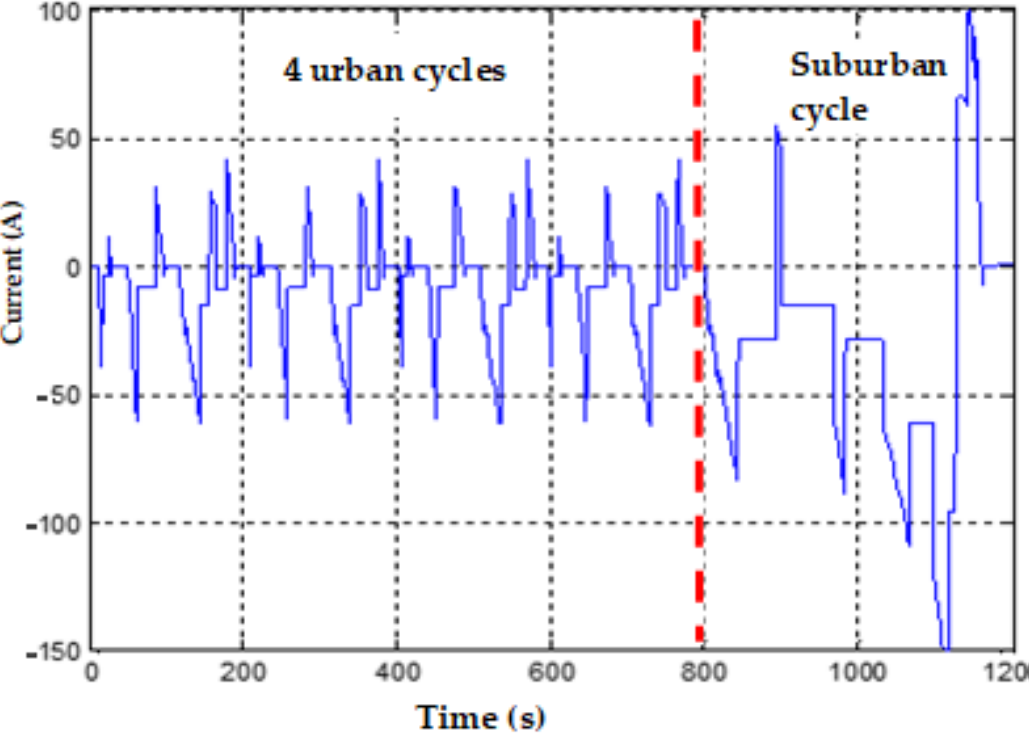
Figure 10. Current profile equivalent to a NEDC